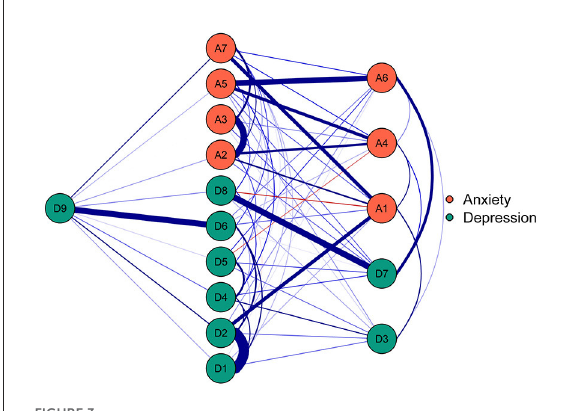
FIGURE3 The flow network of death thoughts in the functionally impaired elderly. The nodes in the network represent symptoms of anxiety and depression, and the edges represent correlations of symptoms. Blue edges and red edges represent positive and negative correlations, respectively, and thicker edges represent higher